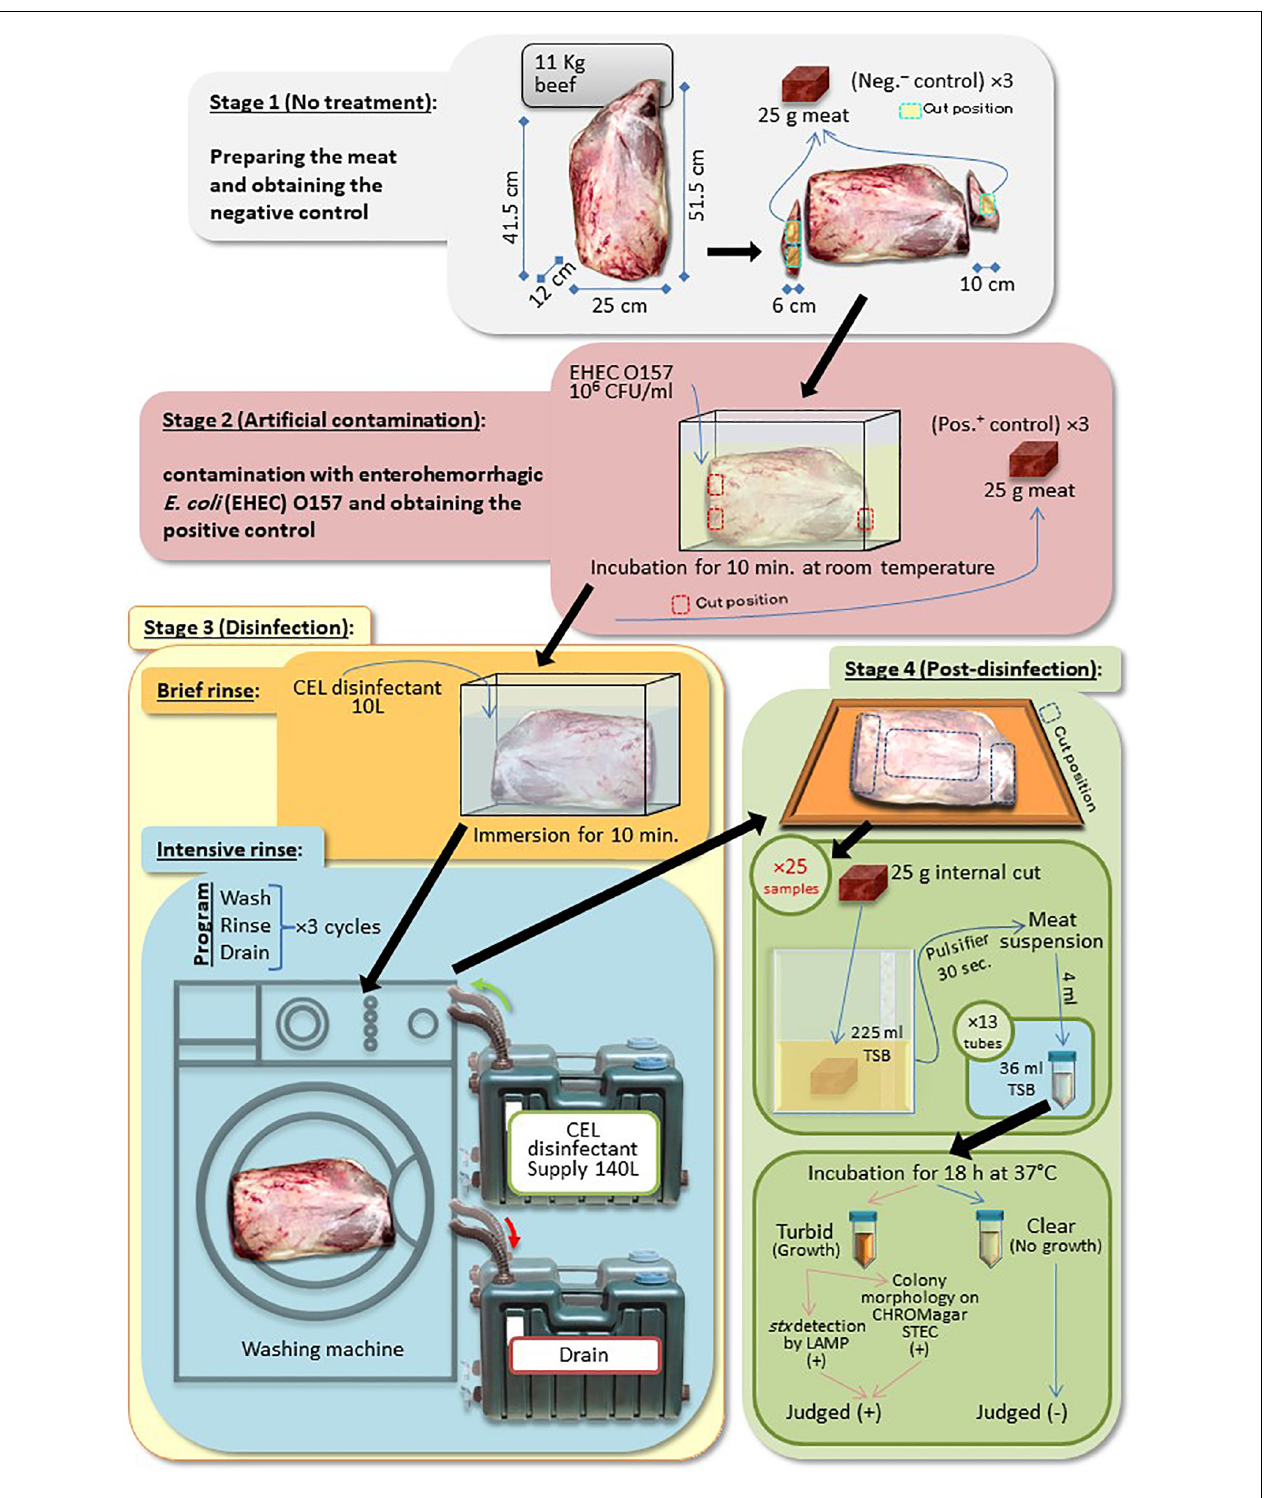
FIGURE 4 | A summarized protocol of the washing machine disinfection (WM) method.